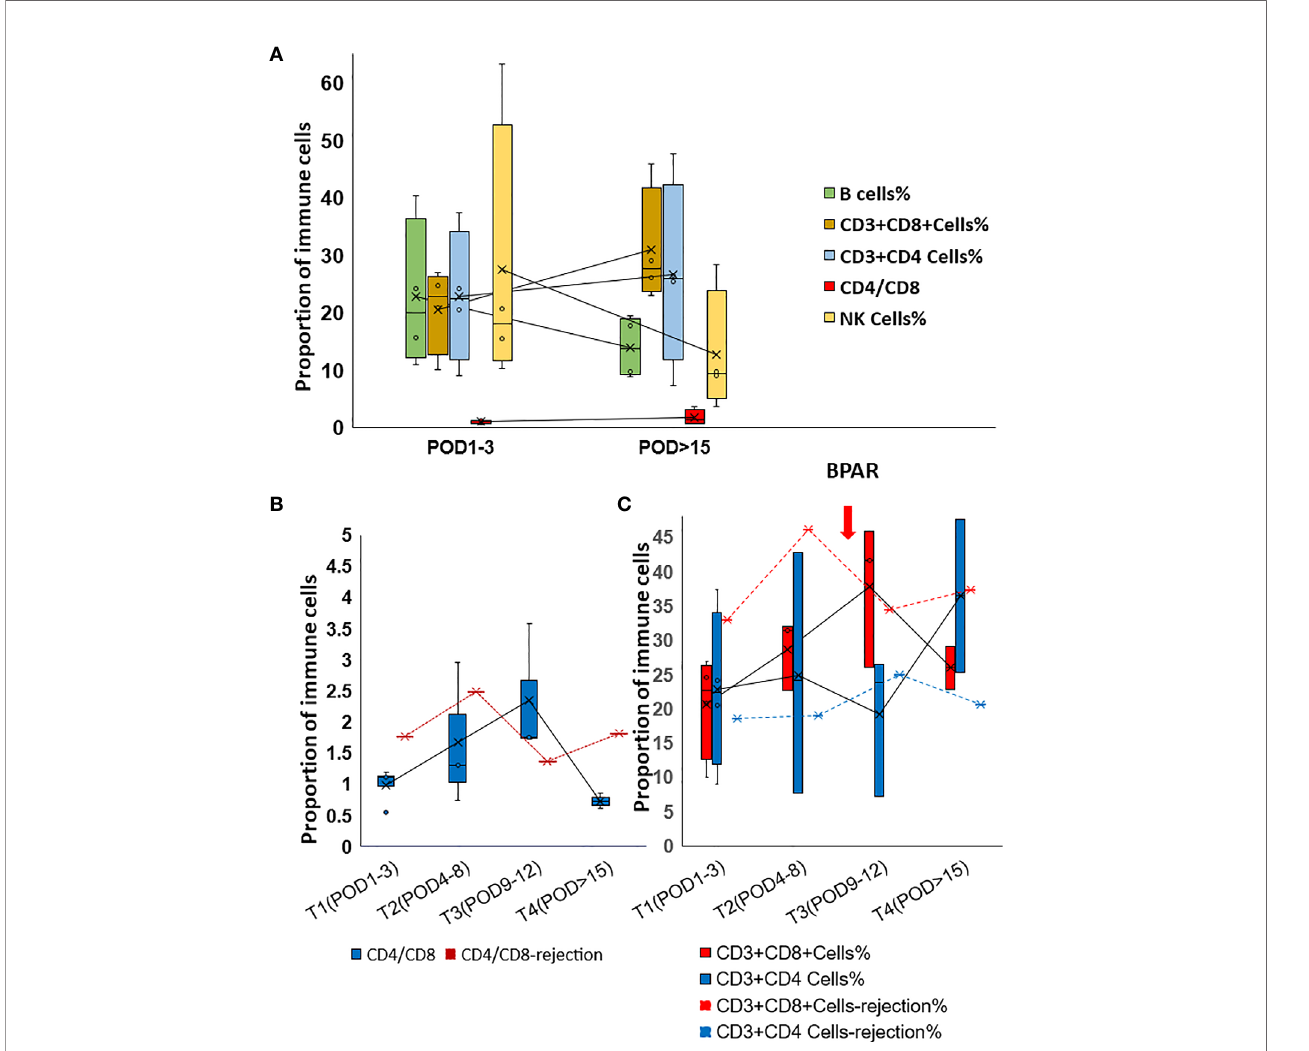
FIGURE 3 | Alteration of the proportion of Immune cells in post-transplant set-up. (A) Changes of lymphocyte percentages and CD4/CD8 ratio in cohort 1 patients. (B) Changes of CD4/CD8 ratio in rejection and non-rejection patients. (C) Changes of lymphocyte percentage in rejection(red dot line and blue dot line) and non- rejection